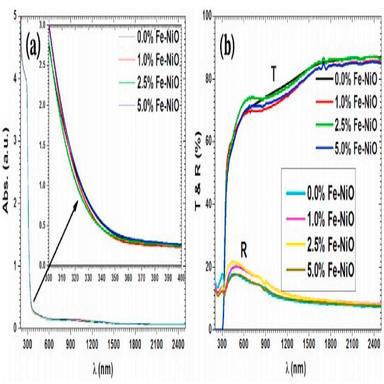
(a) Absorbance and (b) transmittance and reflectance spectra for all Fe: NiO films.